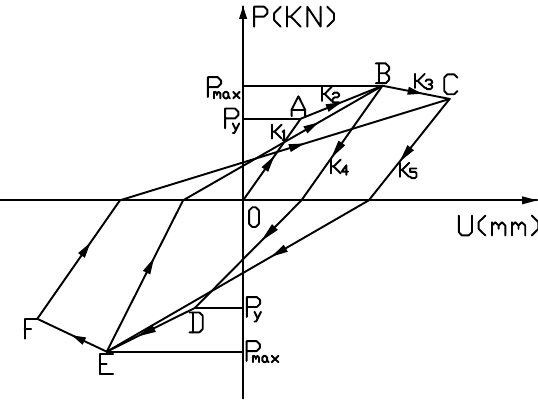
Figure 14. The restoring force model of the framework.